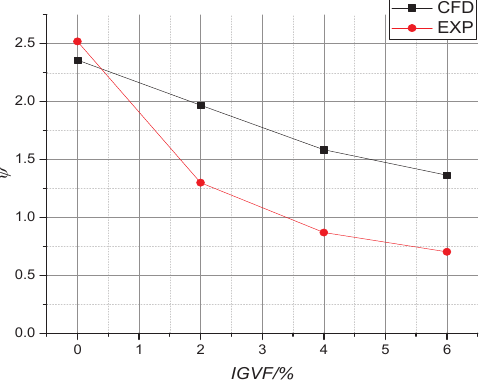
Figure 10. Performance curve comparison of the test pump.